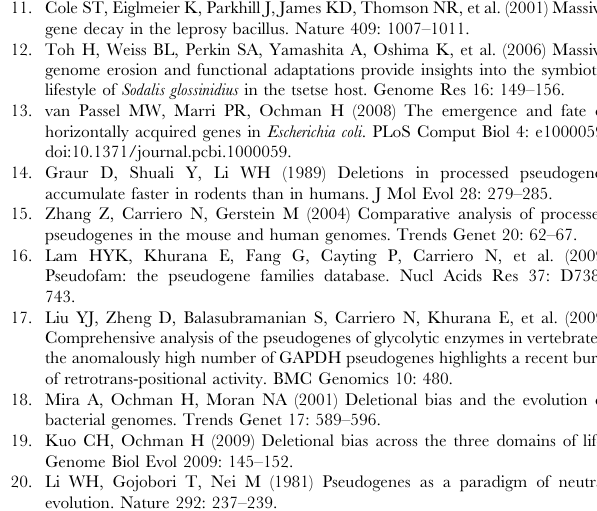
Table S1 List of pseudogenes detected and